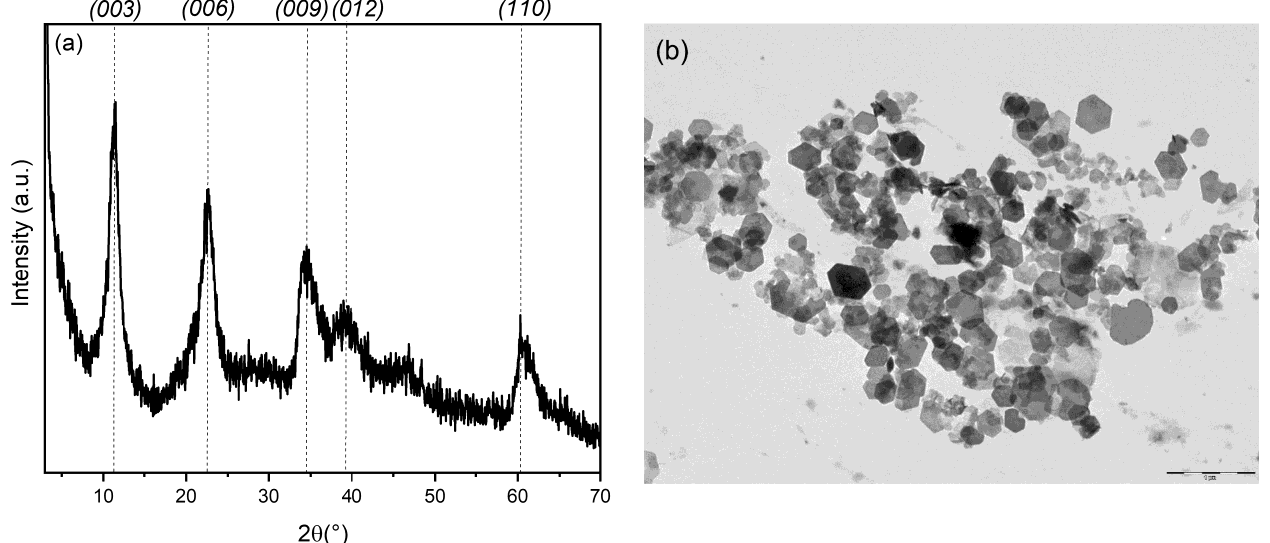
Figure 1. XRD pattern ( a ) and TEM image ( b ) of ZnAl-Br; the bar correspond to 1 μ m. To promote the intercalation of larger species, the basal space of LDH was expanded by substituting the bromide ions with acetate ions through an ion exchange reaction. After 12.5 Å (Figure 2a, blue pattern). The ZnAl-Ac sample obtained was used as a precursor for were tailored according to their specific solubility, as reported in the experimental